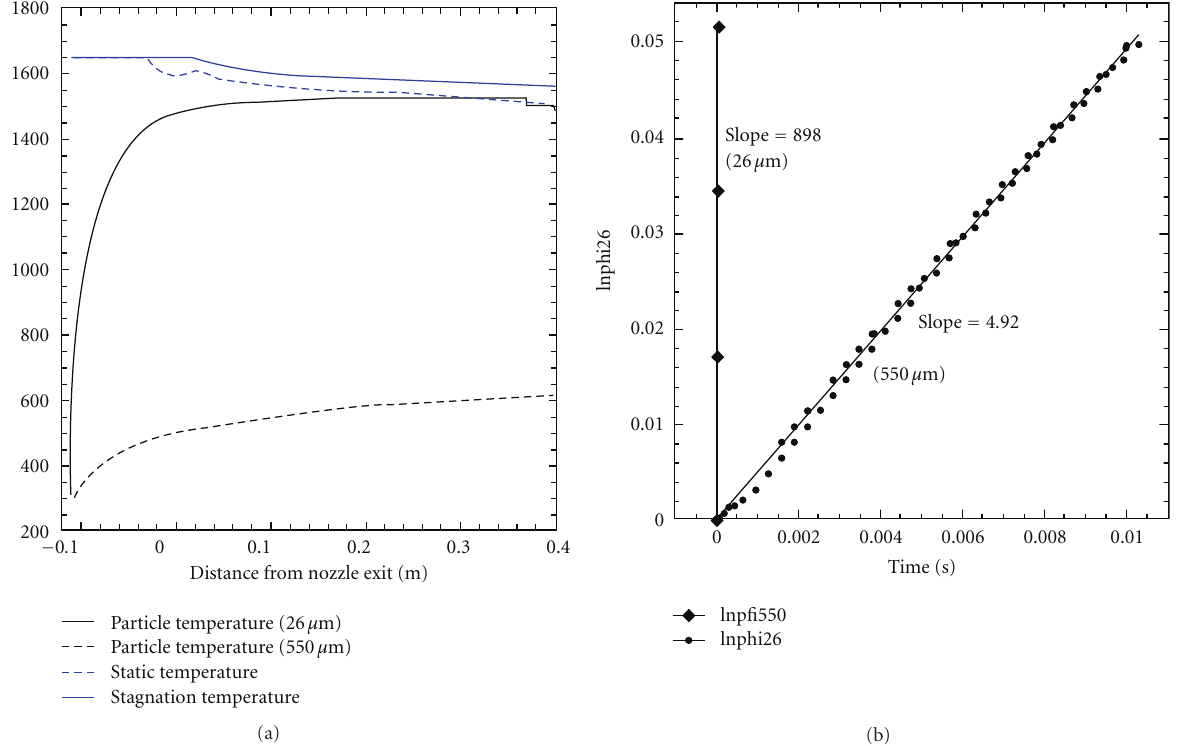
Figure 10: (a) Plot of particle temperatures for 26 and 550 micron diameter particles and gas static and stagnation temperature as a function of distance from the nozzle. (b) Plot of the logarithm of temperature ratio versus time for the early stages of particle heating for 26 and 550 micron